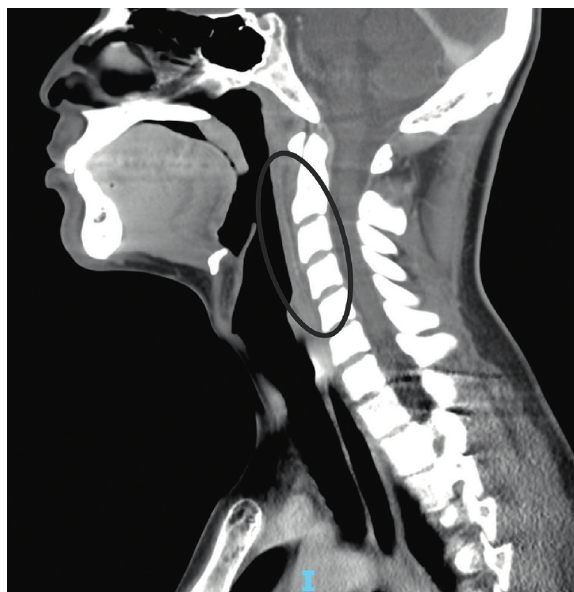
Figure 2: Decrease in the previously noted retropharyngeal